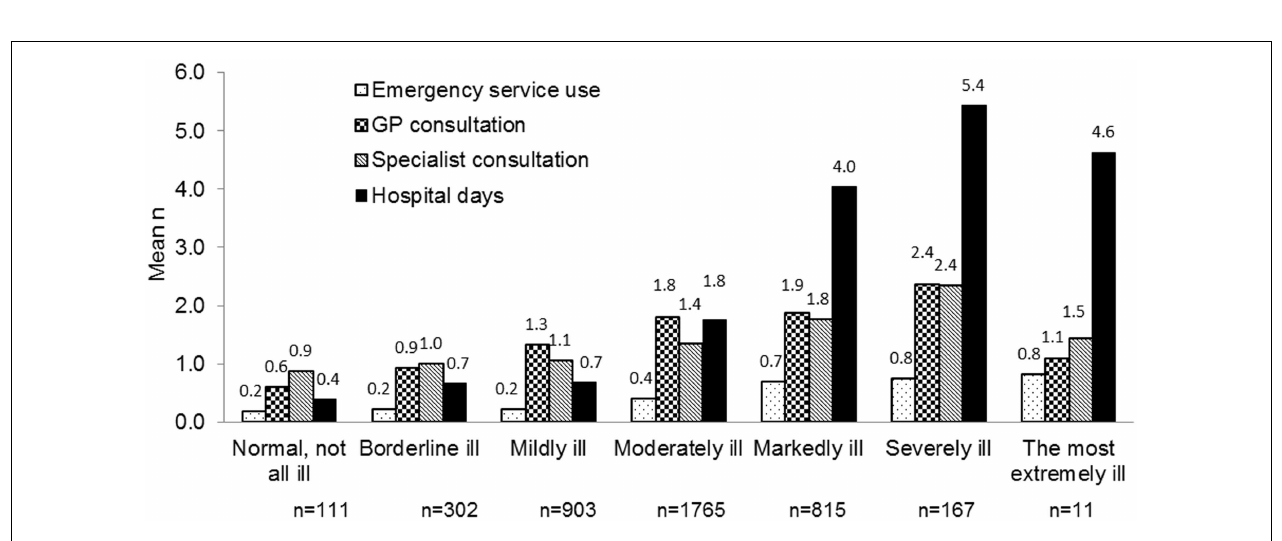
FIGURE 2 | Healthcare utilization by patients with vertigo during the 3months beforeVisit 1 by illness severity